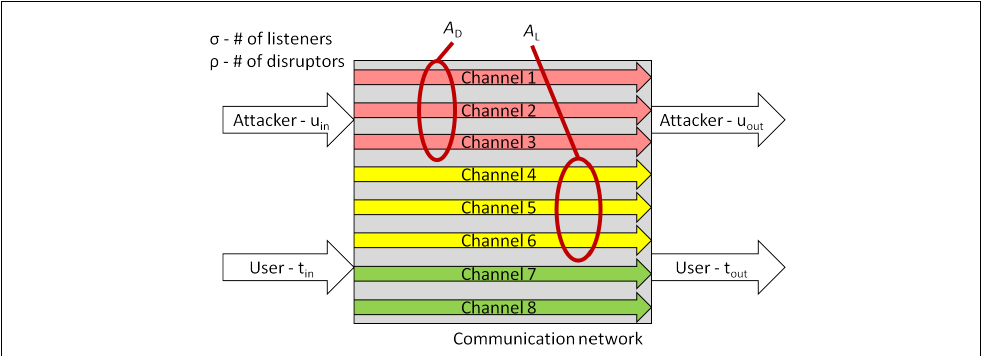
Figure 1. A network configuration with multiple possible